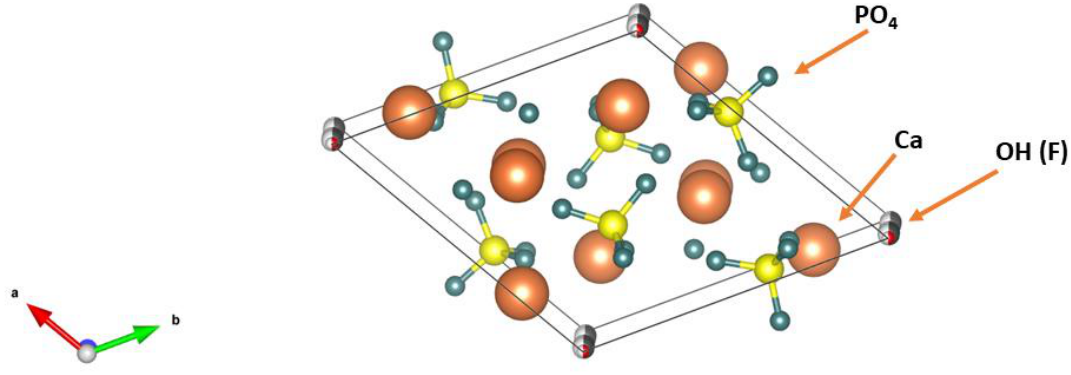
Figure 3. Schematic pictures of unit cells for: a) HA and b) FA.